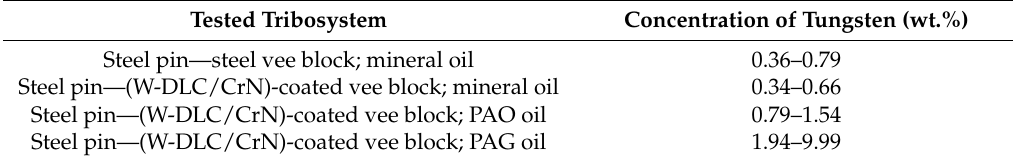
Table 4. The traces of tungsten on the worn surfaces of the test pins.